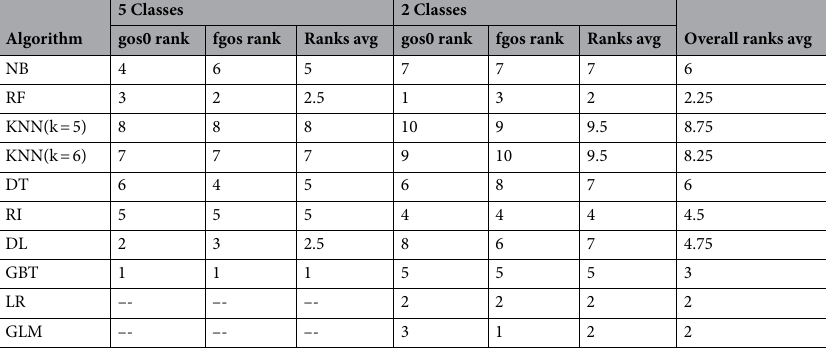
Table 12. Rank-based analysis of investigated algorithms: avg stands for